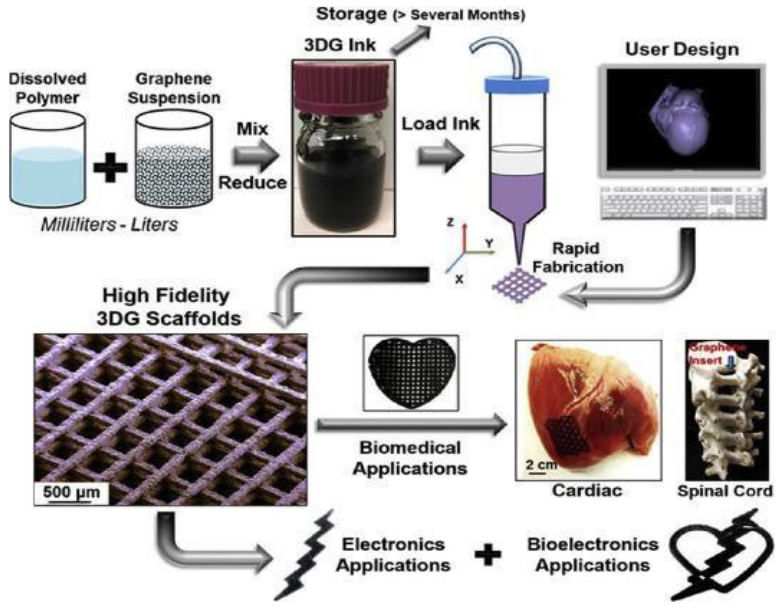
Figure 7. Production of a 3D printable graphene composite scaffold for biomedical application [78]. Copyright 2015, American Chemical Society.